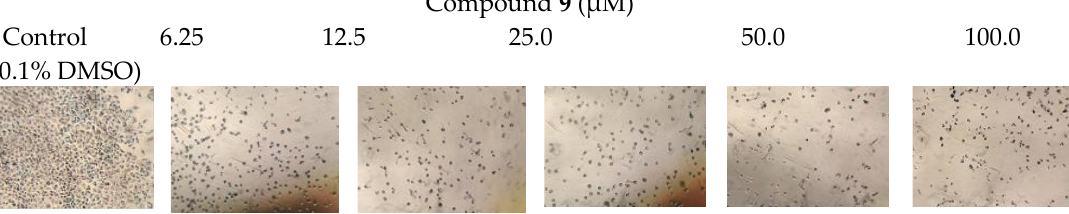
Figure 6. Photomicrographic images of A549 cells depict increasing morphological toxicity include cell monolayer disruption and cell shrinkage with 48 h exposure to 9 at increasing concentrations. Magnification = 150×.